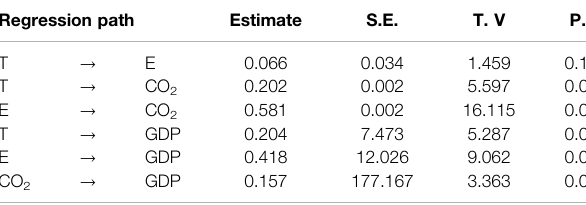
TABLE 6 | Regression weights for Latin American region. Regression path